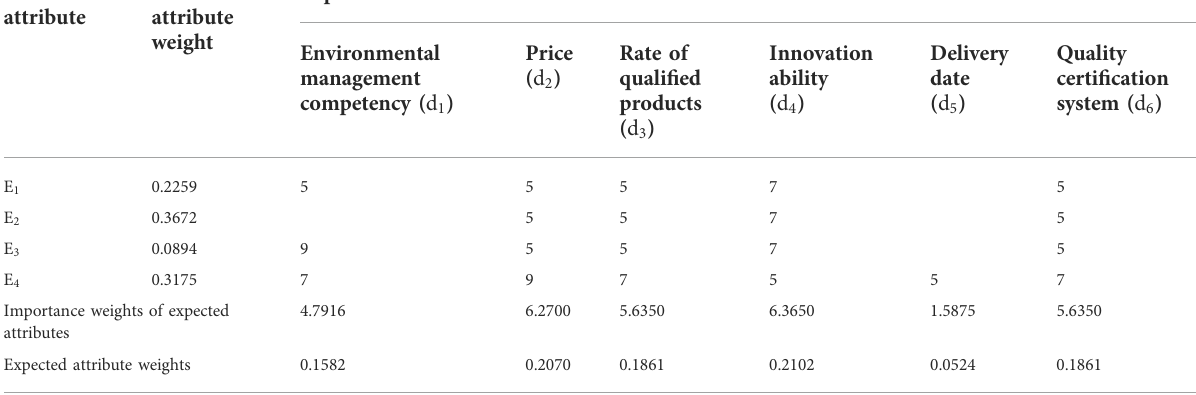
TABLE 12 Relationship matrix between demand attributes and expected attributes.